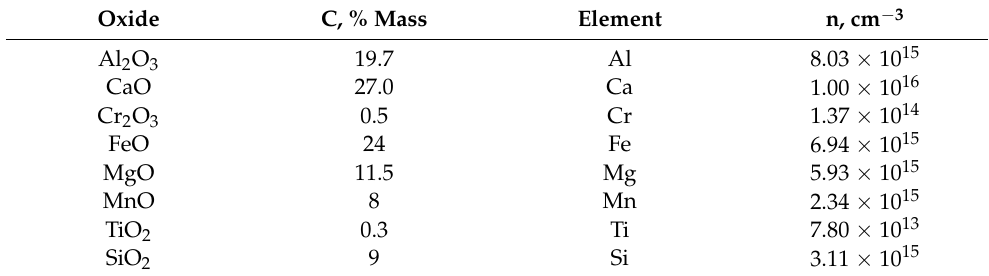
Table 1. Concentrations of oxides and corresponding number densities used to generate synthetic spectrum .